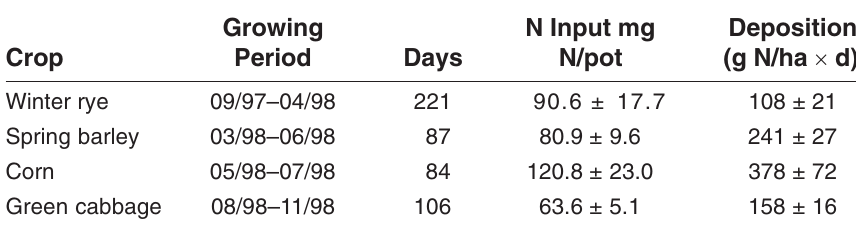
Results of the ITNI Measuring Period 1997/98